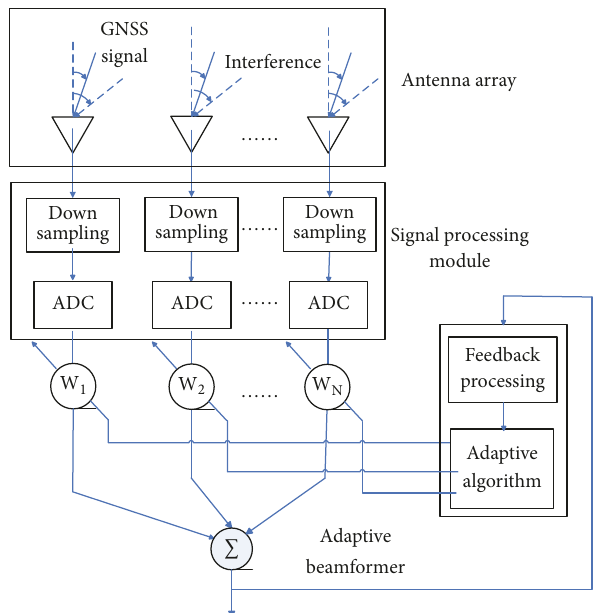
Figure 1: The schematic of a linear antenna array processor in GNSS